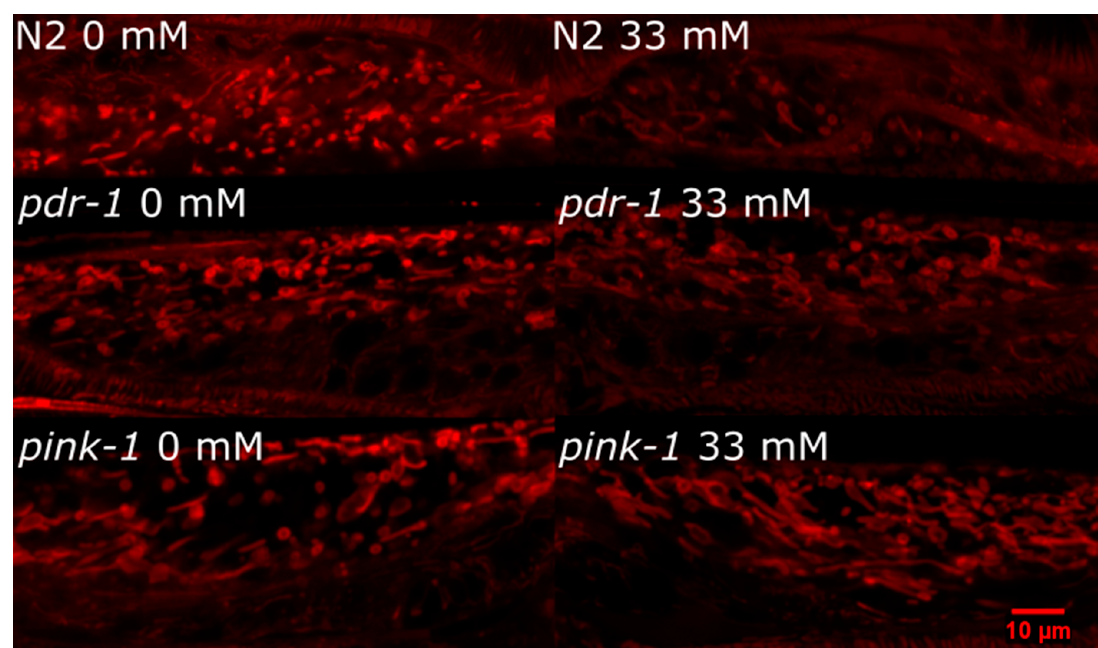
Figure 7. Mitochondrial morphology is not dramatically altered in pink-1 or pdr-1 mutants after 6-OHDA exposure compared to N2 (wild-type) animals. For experiments, worms (wild-type and mitophagy-deficient mutants crossed into the BY200 transgenic reporter strain) were exposed to 6-OHDA as in other experiments. Following exposure, mitochondrial morphology was visualized using MitoTracker CMXRos (incubated with worms for final 4 h of 24 h recovery after exposure). Confocal imaging was performed on animals immobilized with tetramisole and mounted on an agarose pad as described in Methods.